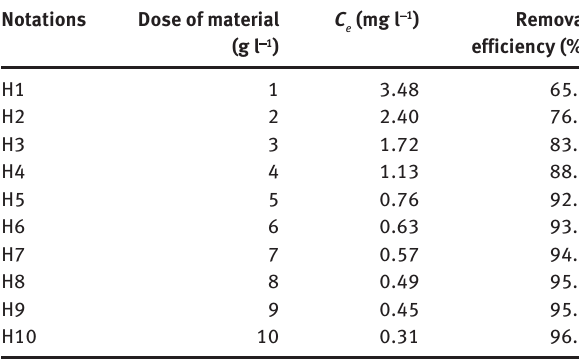
Table 8: Fluoride adsorption efficiency of RHA/Al(OH) well-water.